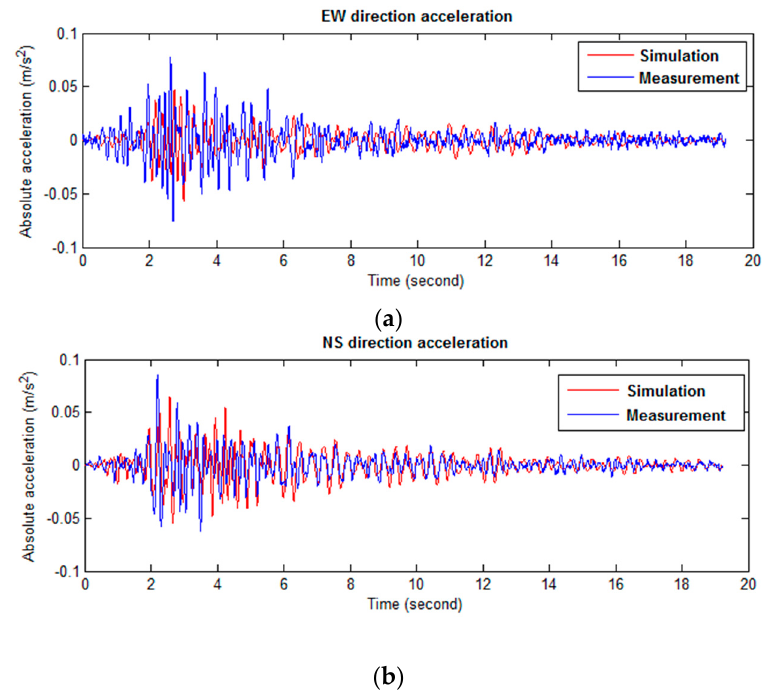
Figure 19. Time history comparison between predicted and measured roof accelerations for 10/16/2012 Hollis Center Maine earthquake ( a ) EW directional acceleration time history; ( b ) NS directional acceleration time history.